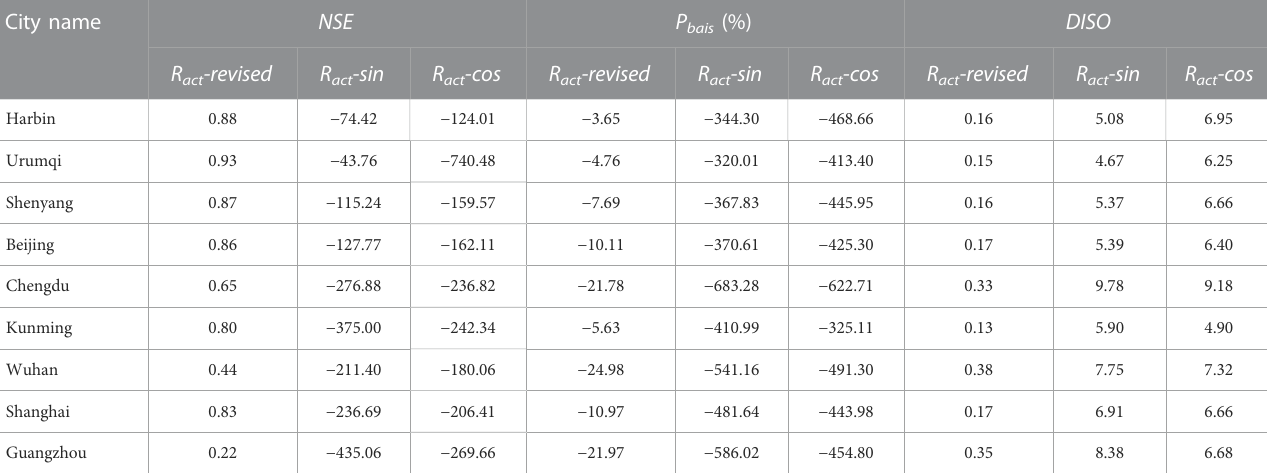
TABLE 4 The effectiveness assessment of the R act is calculated by three